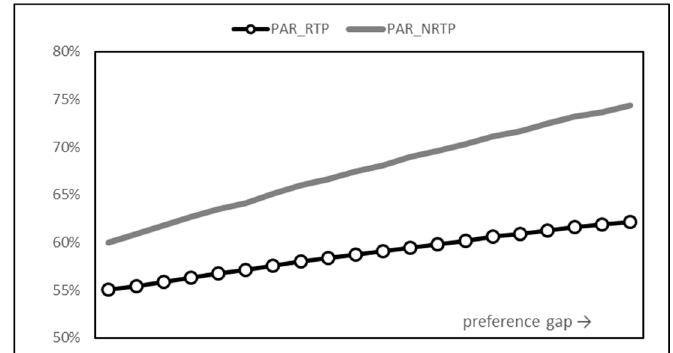
Figure 6. Peak-to-average ratio (PAR) graph.